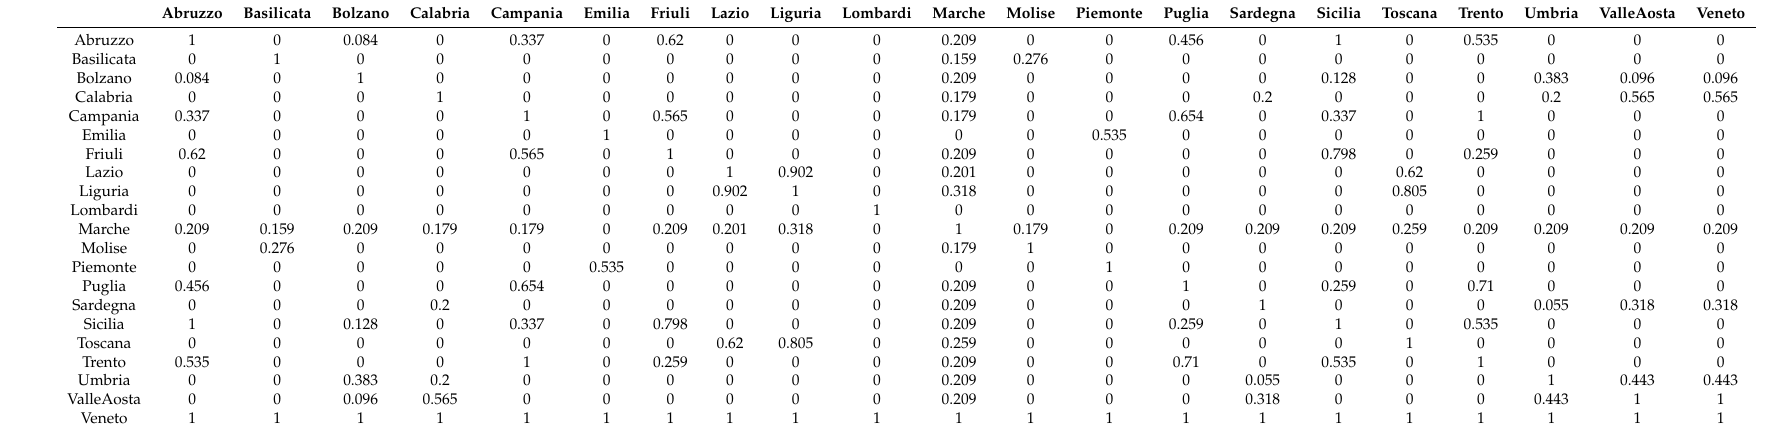
Table A5. Similarity values of Hospitalized with Symptoms network in the fourth week.